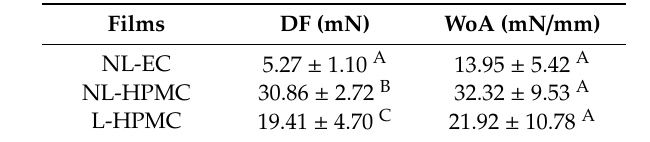
Table 4. Parameters of mucoadhesion properties for nonloaded (NL-HPMC) and loaded (L-HPMC) mucoadhesive films. Values are presented as mean ± standard deviation ( n = 4). Different superscript letters in each column indicates statistical differences for each parameter by one-way analysis of variance with Tukey’s multiple comparison tests ( p < 0.05).